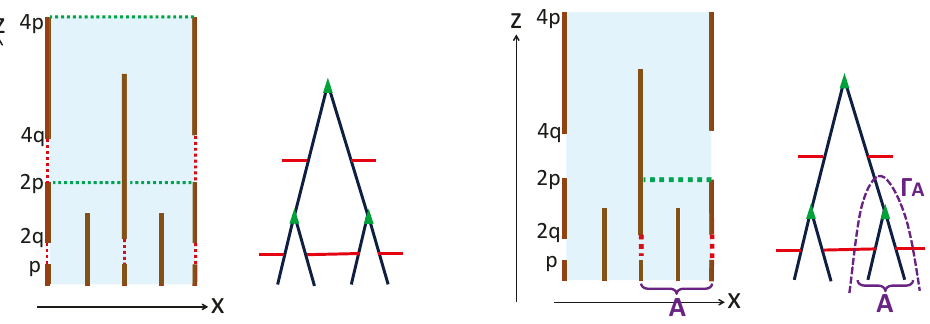
Figure 28 . A sketch of the time slice of our proposed AdS 3 = BCFT 2 setup dual to a MERA-like tensor network (left two pictures), and the estimation of EE S A in the AdS/BCFT and tensor network (right two pictures). The blue region in each picture is the bulk time slice and we added its tensor network description in its next right. The brown thick lines are the slits created by the boundary surface Q in the AdS/BCFT. The red lines and green triangles in the tensor network describe the disentanglers and the coarse-graining tensors. The red and green dotted lines are the geodesics whose length compute the holographic entanglement entropy, corresponding to the entanglement removed by the disentanglers or coarse-graining tensors. We ignore the back-reactions just for simplicity and choose the locations of the slits such that the values of the EE for each red/green dotted lines are the same, which leads to the scale invariance. By comparing the right two pictures, we (cid:12)nd that the calculation of HEE in our AdS/BCFT setup is equivalent to that for the tensor